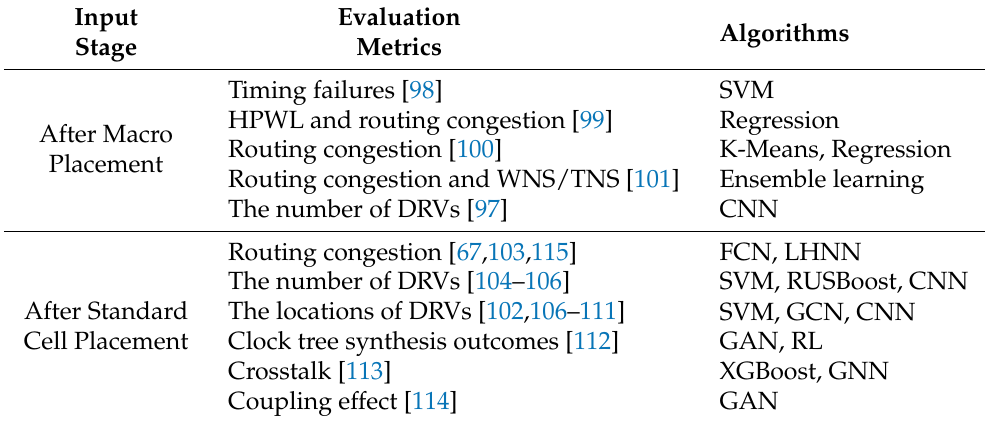
Table 5. Recent studies on learning-based